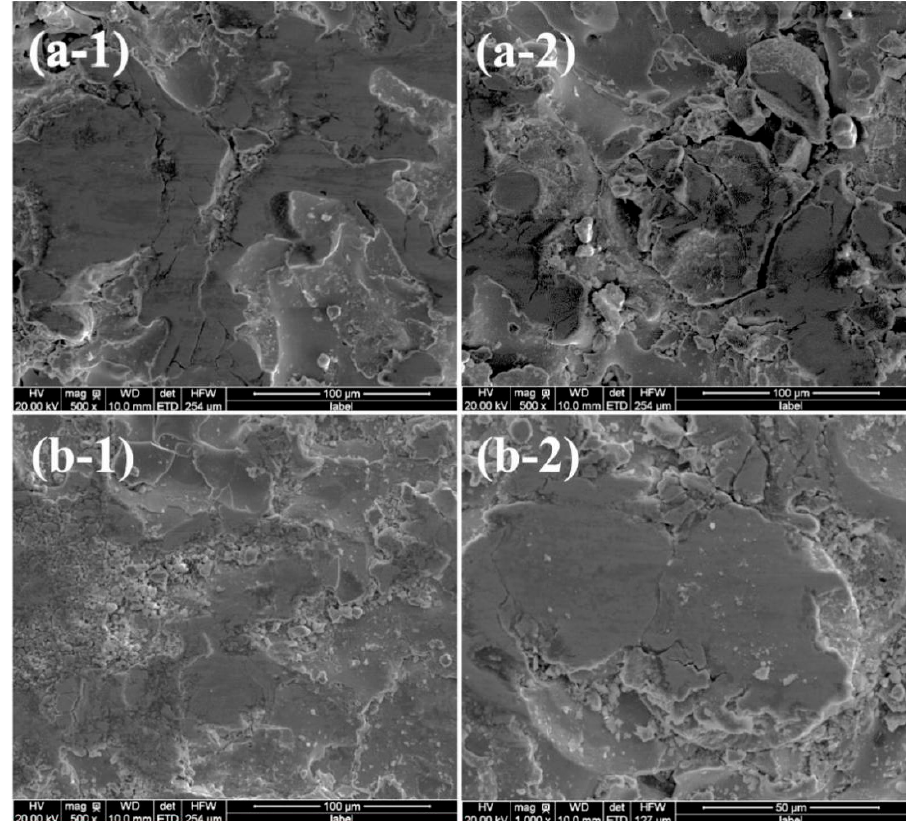
Figure 8. Surface morphology of ( a-1 , a-2 ) plasma sprayed NiCrBSi coating and ( b-1 , b-2 ) post heat- treated NiCrBSi coating before and after friction and wear test.